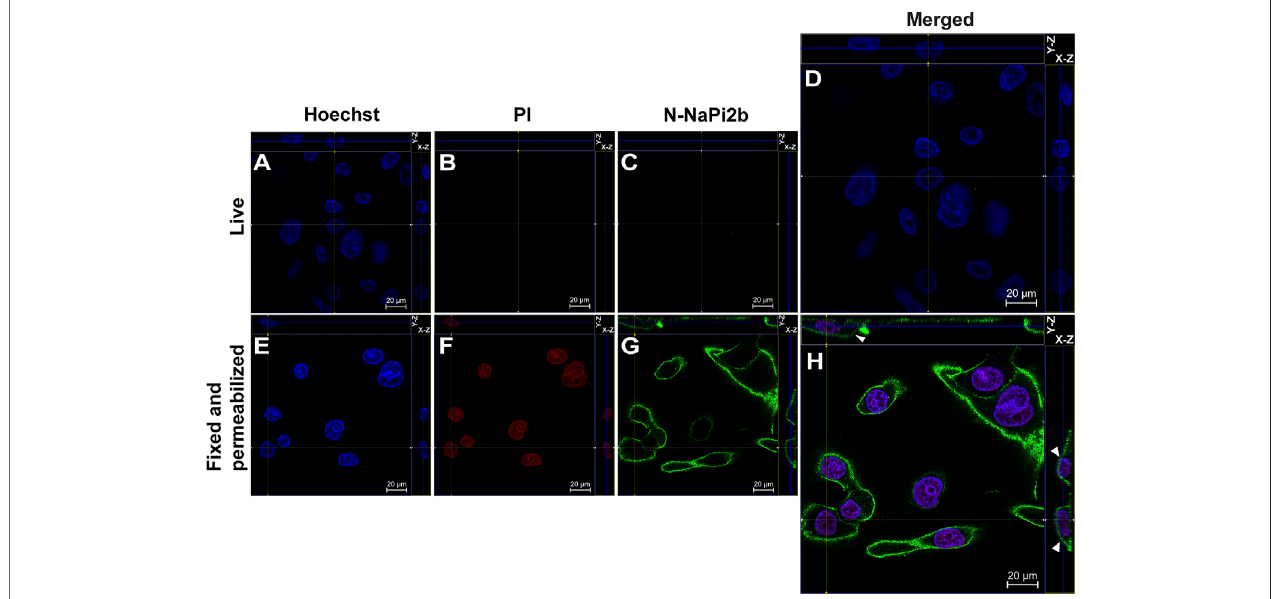
FIGURE 2 | Confocal microscopy analysis of the N-terminal domain of NaPi2b in ovarian carcinomas cells OVCAR-4 that were either intact (A – D) or fi xed and permeabilized (E – H) and imaged in the Z-stacking mode. (A,E) Blue channel (Hoechst); (B,F) Red channel (PI); and (C,G) Green channel (Alexa Fluor 488), N-NaPi2b – mAbs N-NaPi2b (15/1) directed to the N-terminal domain of NaPi2b; (D,H) Merged images; On the top ( Y -axis and Z -axis combined) and right ( X -axis and Z -axis combined) of each picture, a composite image comprising of numerous photographs obtained at various focus distances is shown. White arrows indicate the position of NaPi2b on the cell membrane.